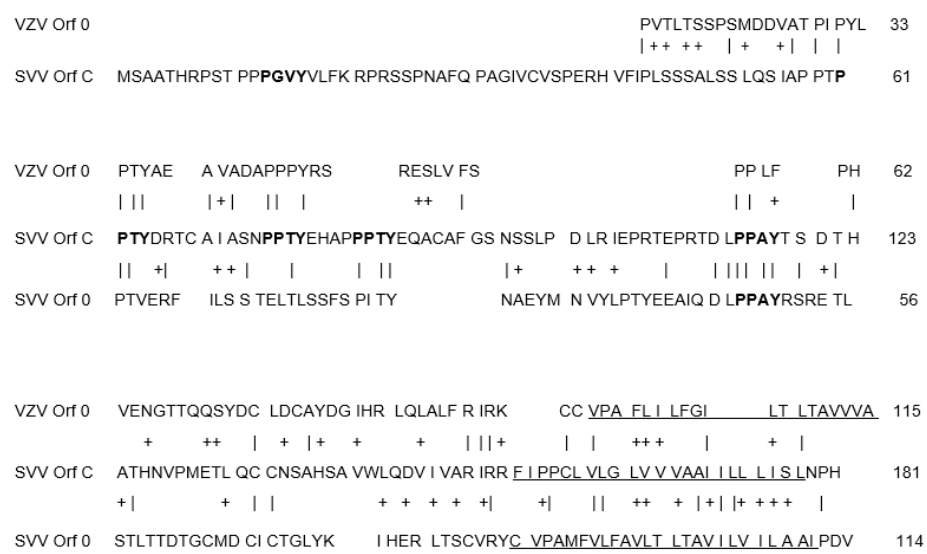
Figure 4. Amino acid alignment of the C-terminal region of the SVV and VZV UL56 homologs including SVV ORFs C and 0 (B) and VZV ORF 0. Vertical lines indicate amino acid identity, and + indicates amino acid similarity. PPRX motifs are in bold. Predicted transmembrane domains are underlined.